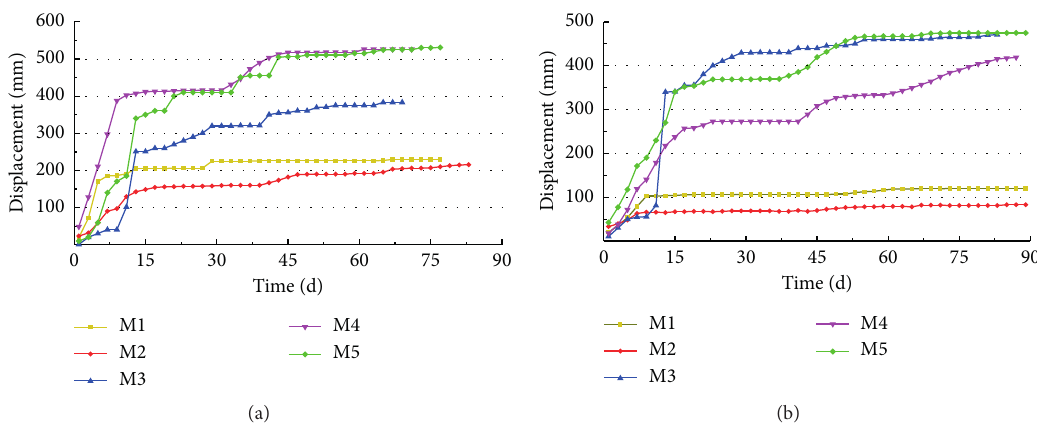
Figure 7: Monitoring results of the surface displacement of Roadway. (a) Displacement of two sidewalls. (b) Displacement of vault.